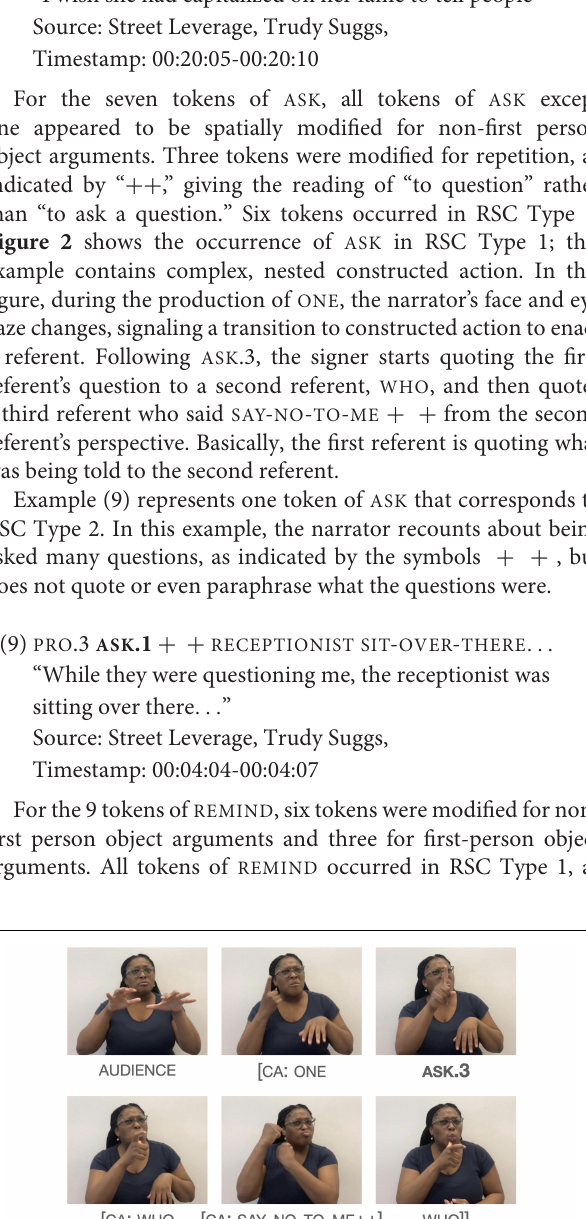
FIGURE 2 | An example of ASK in RSC Type 1. Images produced with permission, source information available in the Supplementary Material